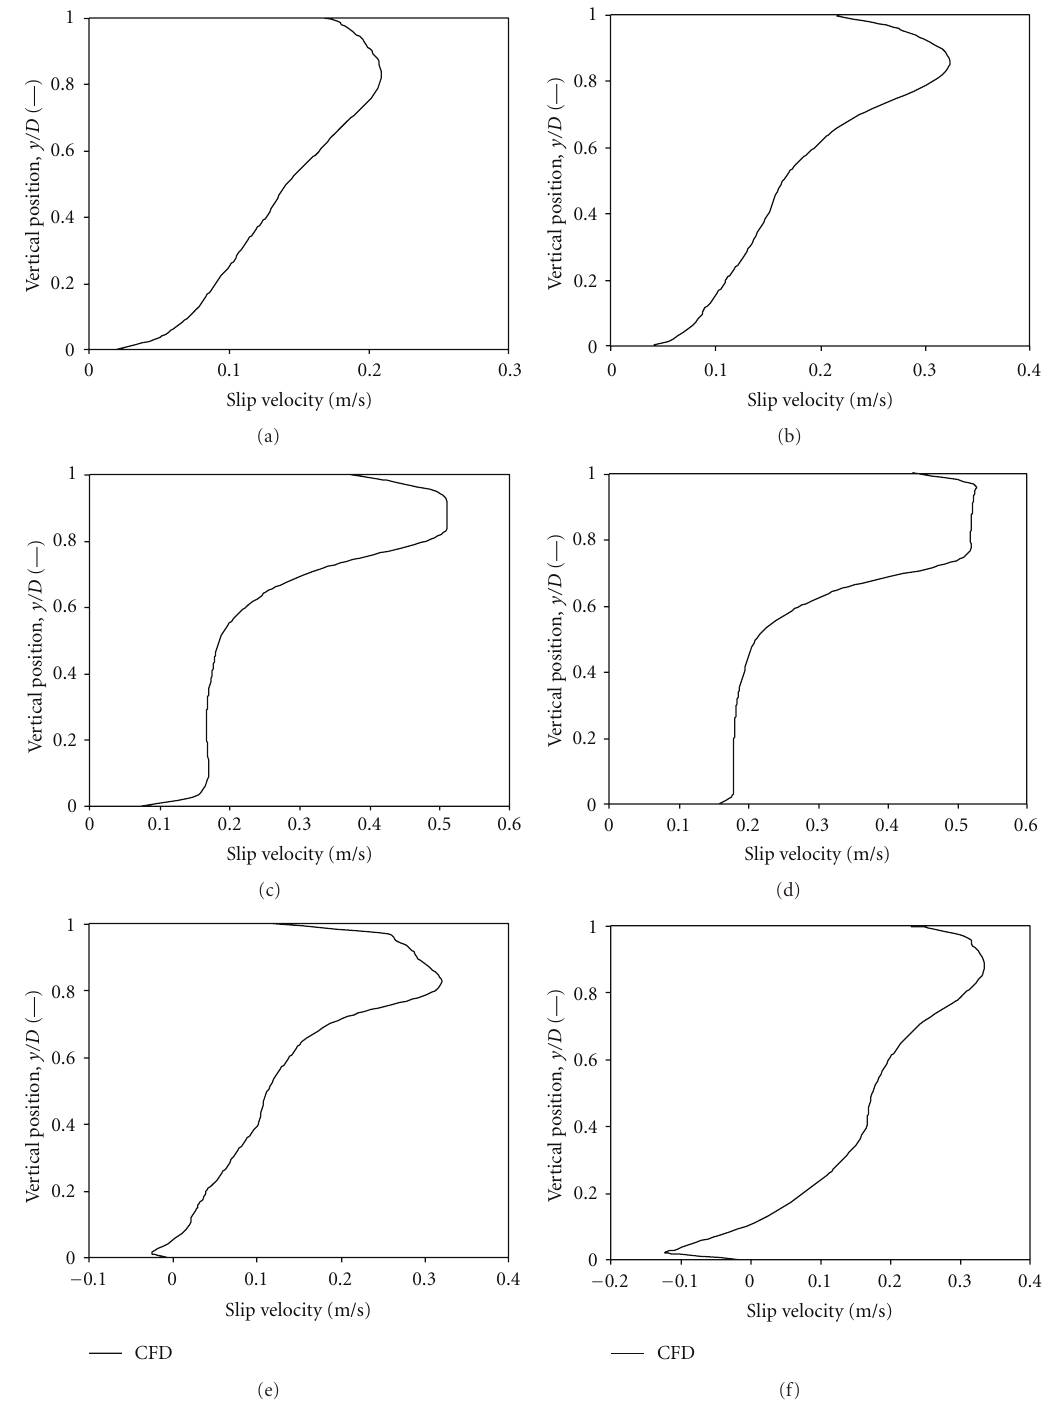
Figure 9: Slip velocity at di ff erent superficial gas and liquid velocities: (a) V G = 0 . 25 m/s, V L = 5 . 1m/s; (b) V G = 0 . 50 m/s, V L = 5 . 1 m/s; (c) V G = 0 . 80 m/s, V L = 5 . 1 m/s; (d) V G = 1 . 34 m/s, V L = 5 . 1 m/s; (e) V G = 0 . 51 m/s, V L = 3 . 74m/s; (f) V G = 0 . 51m/s, V L = 4 . 4 m/s.